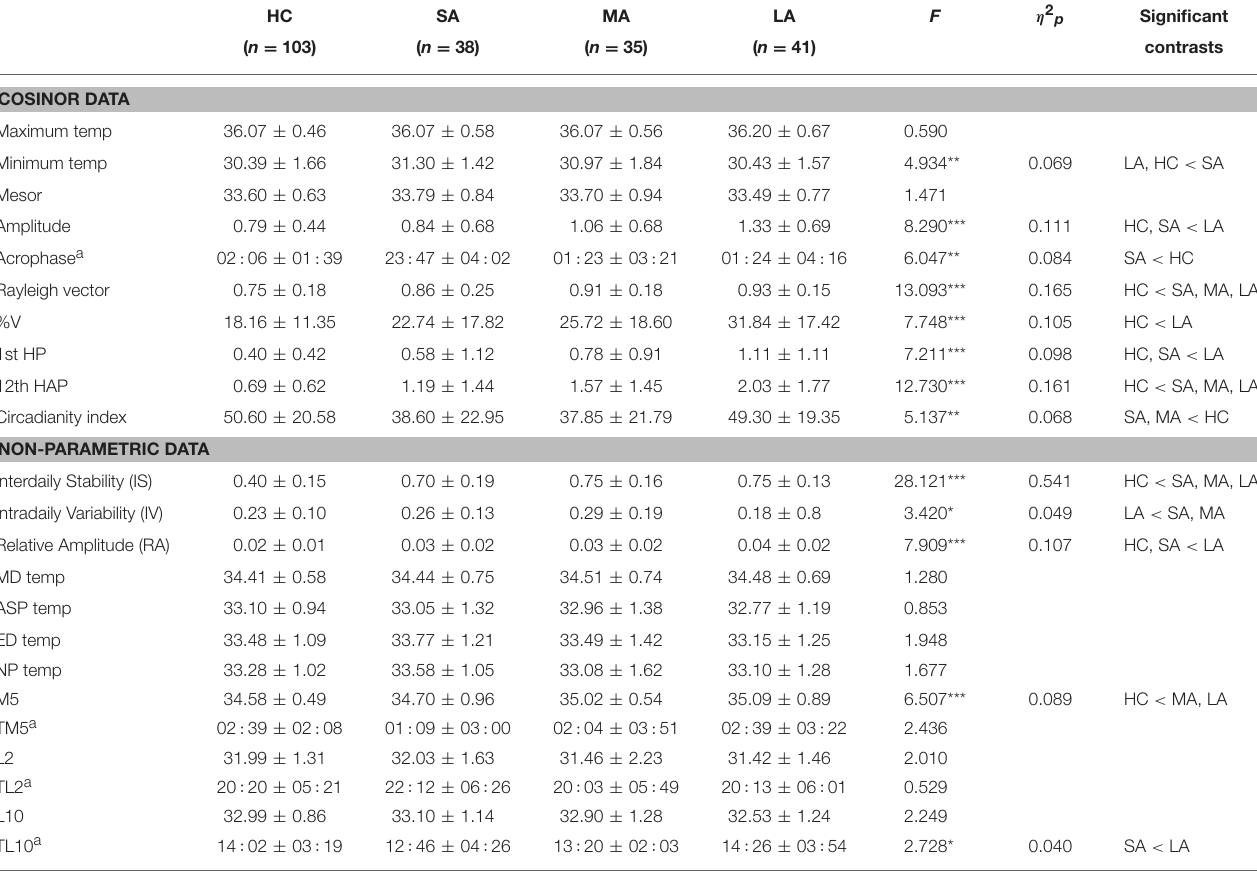
TABLE 5 | Distal skin circadian rhythmic variables for the HC and duration of abstinence groups. HC η 2 p Significant